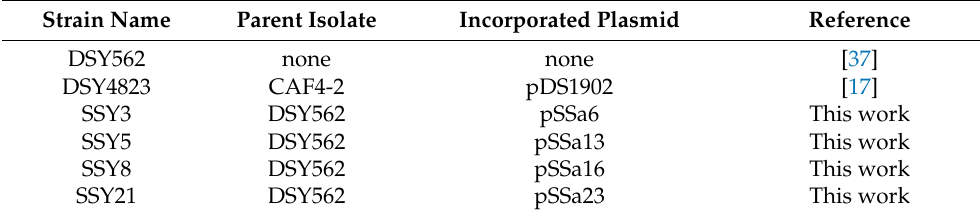
Table 1. List of C. glabrata and C. albicans strains used in this